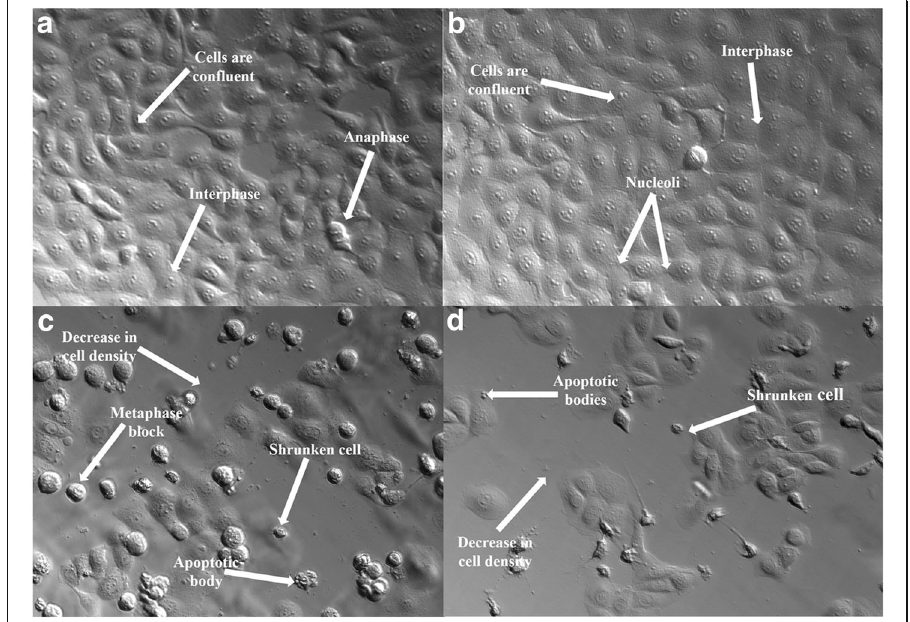
Fig. 3 PlasDIC images of HeLa cells demonstrating the morphological changes induced by ESE-16. a and b Cells propagated in growth medium ( a ) and vehicle-treated control cells ( b ) were confluent, with majority of cells in interphase. c ESE-16-treated cells: several cells are blocked in metaphase and there are visible apoptotic characteris- tics such as shrunken cells and apoptotic bodies. d Hallmarks of apoptosis were observed in the positive control cells, which were exposed to actinomycin D (20×